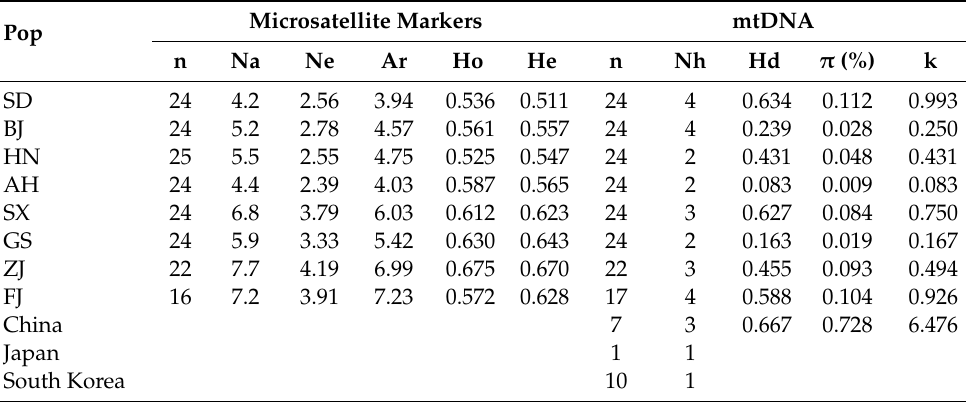
Table 2. The genetic diversity of L. delicatula populations based on 13 microsatellite markers and two mtDNA markers. Pop, population label; n, no. samples; N a , mean number of alleles per marker; N e , mean e ff ective number of alleles per marker; Ar, allelic richness; Ho, observed heterozygosity; He, expected heterozygosity; Nh, no. haplotypes; Hd, haplotype diversity; π , nucleotide diversity; k, average number of nucleotide di ff erences. Thirty-six mitochondrial sequences from China, South Korea, and Japan populations were downloaded from GenBank ( ND2 : KC422353–KC422370; ND6 : KC422371–KC422388).